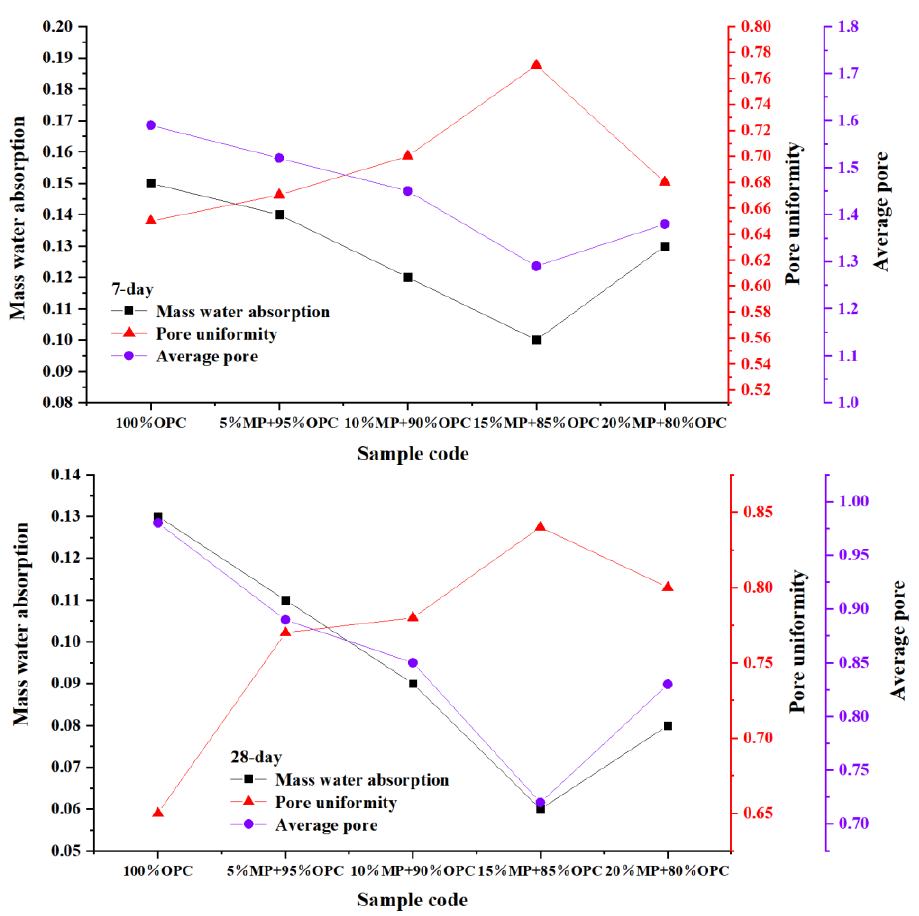
Figure 16. Differentiation of 7-day and 28-day mass water absorption W, pore uniformity α and average pore diameter λ at different MP contents.